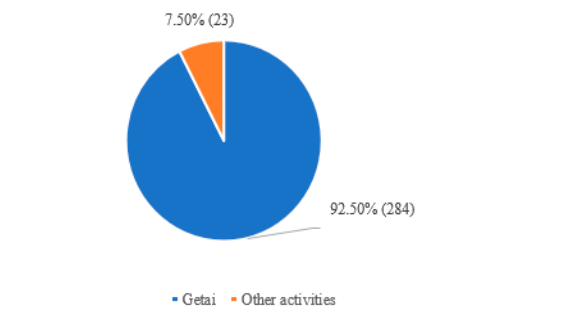
Figure 3. Hungry Ghost Festival activities recorded in Chinese newspapers in 2017.